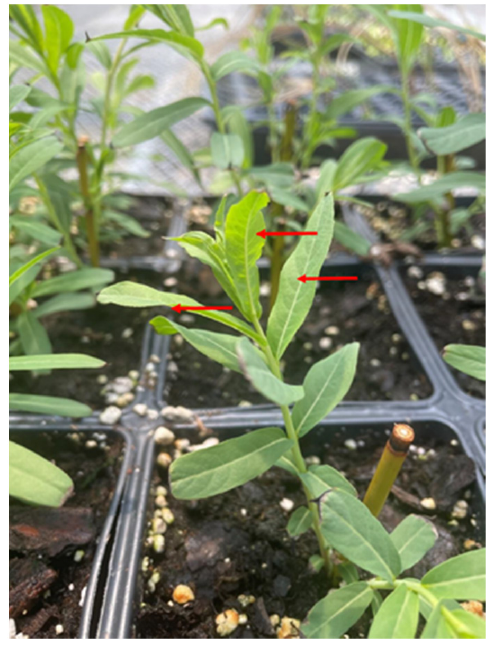
Figure 3. Image of two-week-old cuttings of Salix purpurea clone 94006, arrows point to leaves used for protoplast extraction. for protoplast